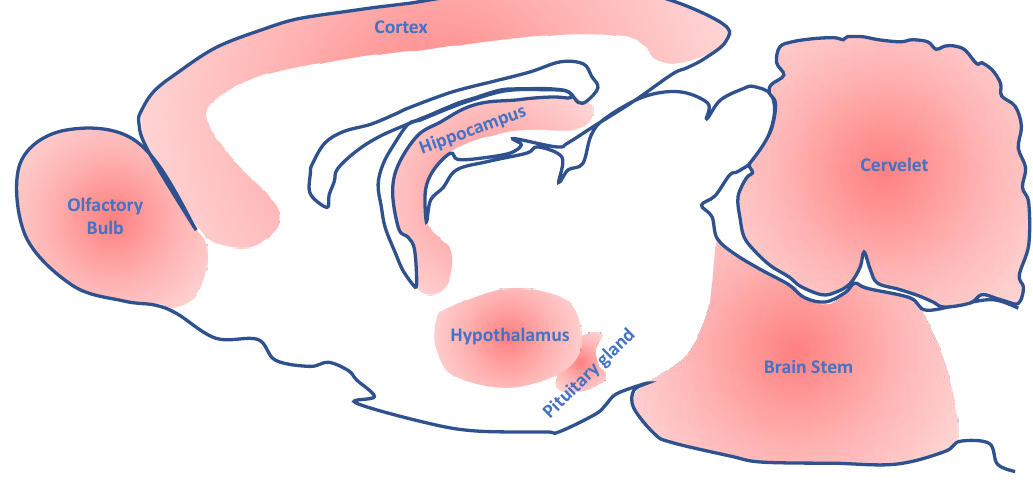
Figure 1. Representation of the rat brain domains that express the aryl hydrocarbon Receptor.